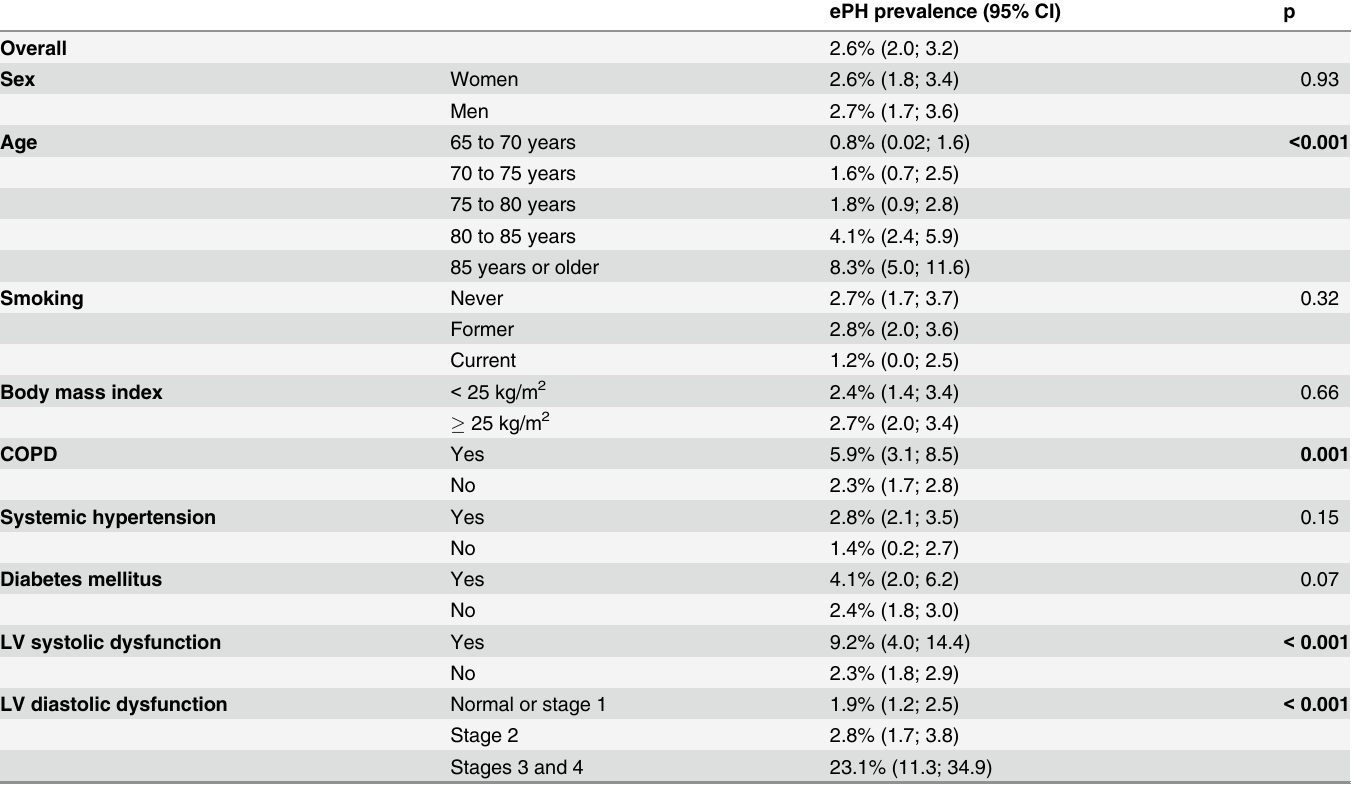
Table 2. Prevalence of echocardiographic pulmonary hypertension, overall and in subgroups.